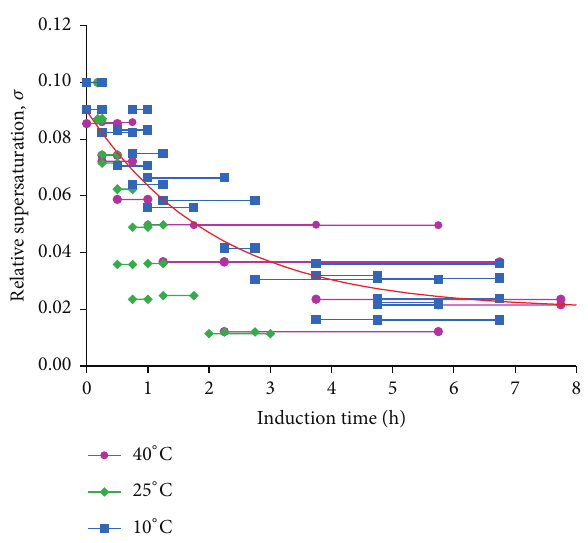
Figure 2: SNT in ethanol at 10, 25, and 40 ∘ C. The curve represents the exponential of best fit (1) to all the data. In the graph the points represent the induction time range between the latest time before nucleation was definitely observed and the earliest time after nucleation definitely was observed. Nucleation must have occurred somewhere between these two times.